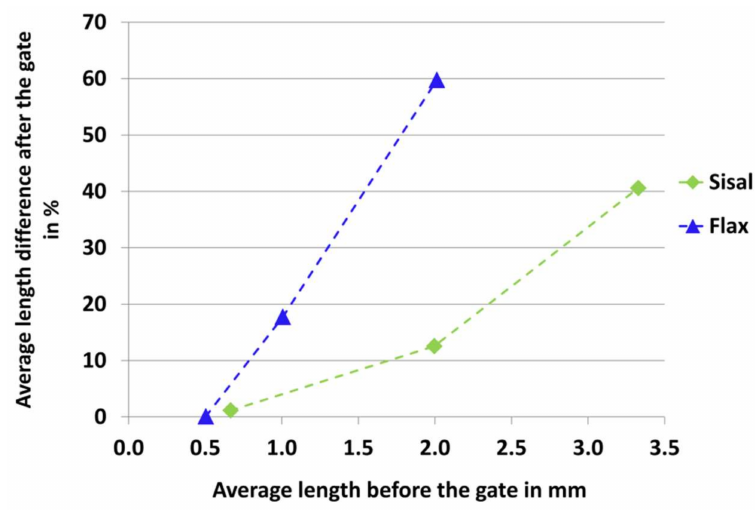
Figure 12. Fibre breakage results of the mechanistic model for flax and sisal. The x-axis shows the average fibre length before the injection moulding process, before entering the gate. The y-axis shows the percentage of the length reduction as the fibres enter the mould after the gate during injection